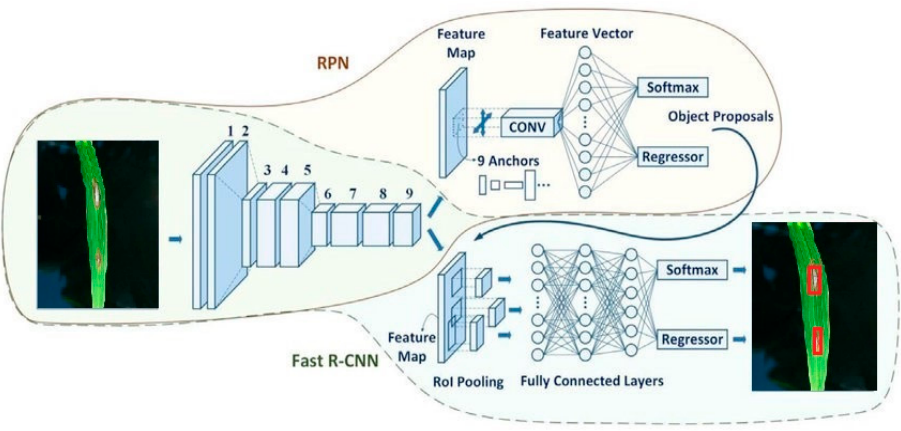
Figure 10. Faster-RCNN model (Cha et al. [57]).